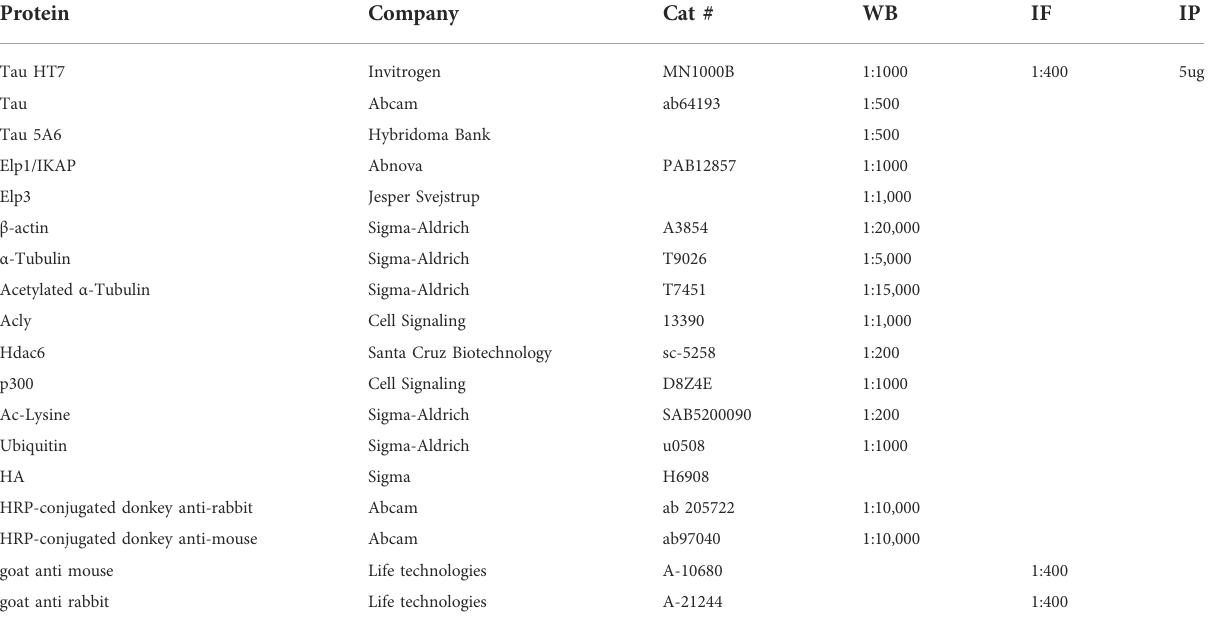
TABLE 1 List of